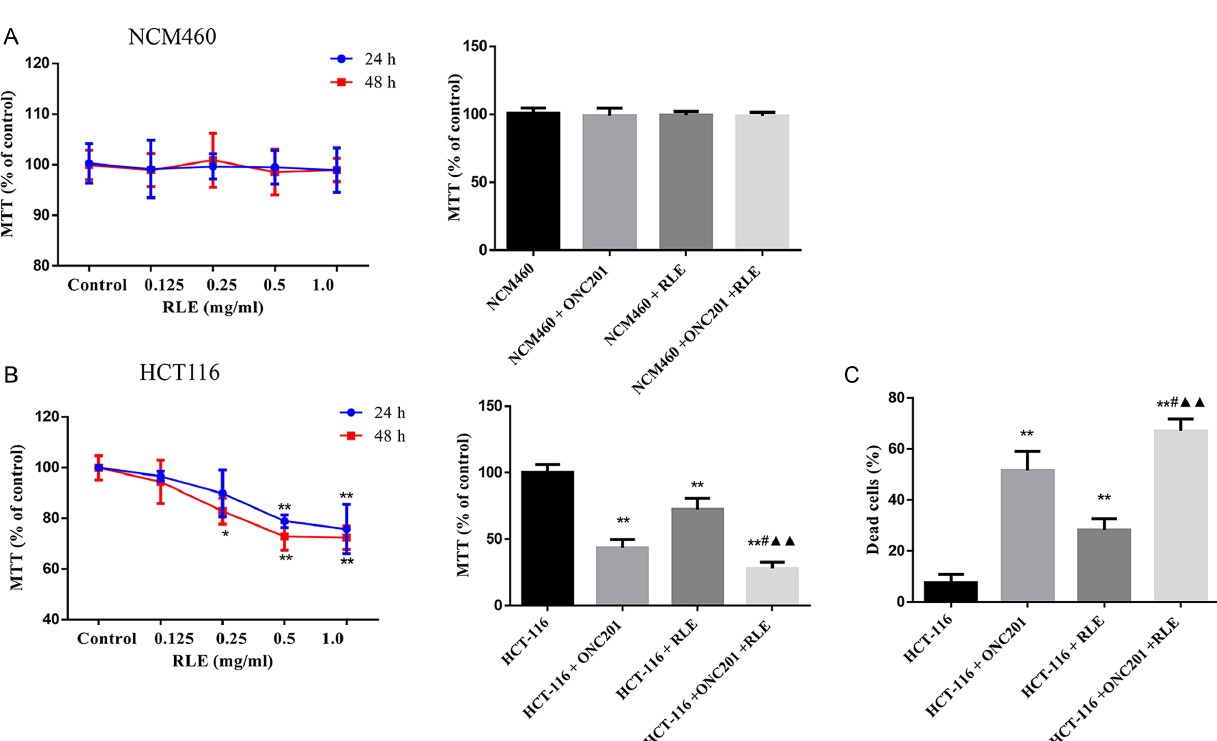
Figure 1. RLE inhibits HCT116 cell viability and strengthens ONC201 induced cell death. (A and B) Cell viability was detected using MTT assay. (C) Cytotoxicity was examined using trypan blue staining assays. * P < .05, ** P < .01 vs. the HCT116 group; # P < .05, ## P < .01 vs. the HCT116 + ONC201 group; ▲ P < .05, ▲▲ P < .01 vs. the HCT116 + RLE group. RLE, raw lacquer